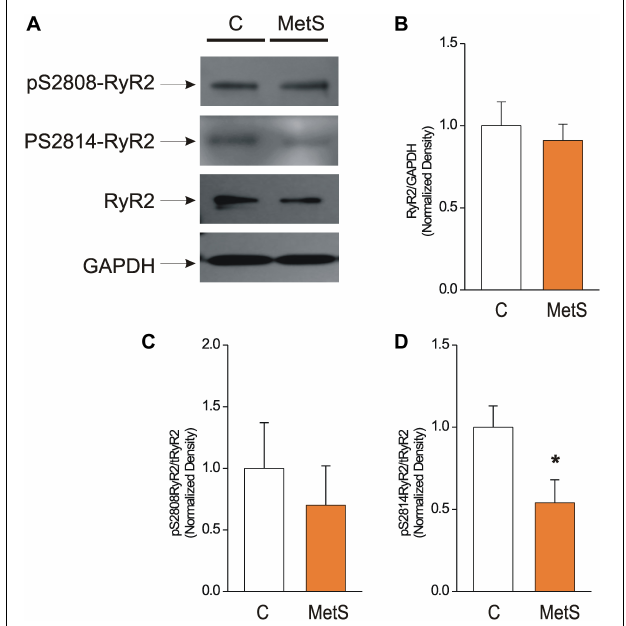
FIGURE 5 | Reduced phosphorylation levels of Cardiac Ryanodine Receptor at Ser-2814 underlie its dysfunctional activity. (A) Representative Western Blot images of phosphorylated RyR2 at Ser2808 (pS2808-RyR2), Ser2814 (pS2814-RyR2), and total ryanodine receptor (RyR2) in whole heart homogenates of control (C) and MetS rats. GAPDH signals were used as loading controls. 50 µ g of protein from whole heart homogenates of each experimental group (C and MetS) were subjected to 4–16% gradient SDS-PAGE, blotted onto PVDF membranes during 2 h, and probed with the respective primary and secondary antibodies. Bar graphs indicate normalized expression levels of total RyR2 (B) , pS2808RyR2/RyR2 total (C) , and pS2814RyR2/RyR2 total (D) in whole heart homogenates of control (C, white bars ) and MetS ( orange bars ) rats. N = 6–7 heart preparations for each experimental group. All values in graphs are presented as Mean ± SEM. ∗ P < 0.05 vs. control